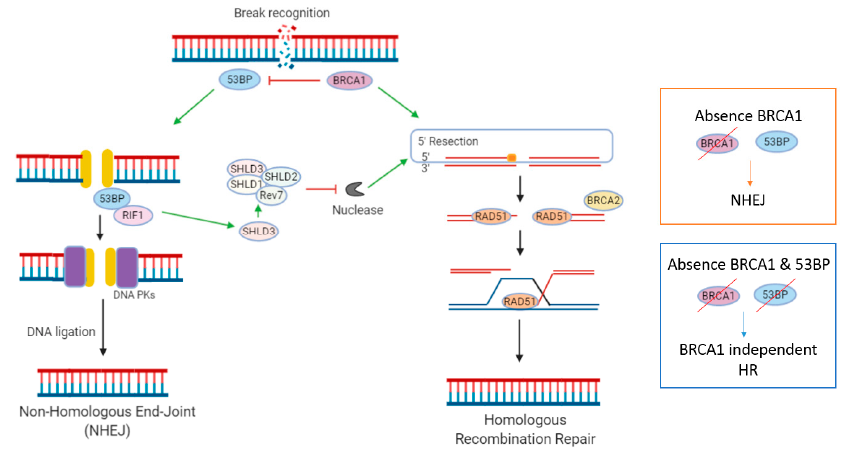
Figure 1. DNA Double Strand Break repair by Homologous Recombination or Non-Homologous End-Joining pathway. Figure: In the absence of functional BRCA1, DNA Double strand breaks (DSBs)